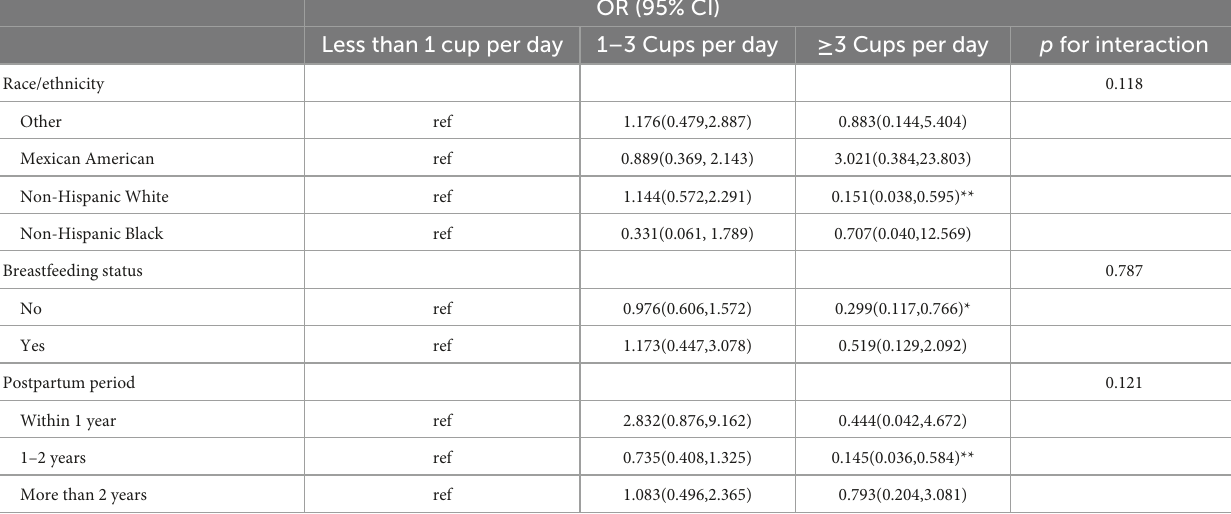
TABLE 3 Association between caffeinated coffee intake (cup/day) and PPD stratified by